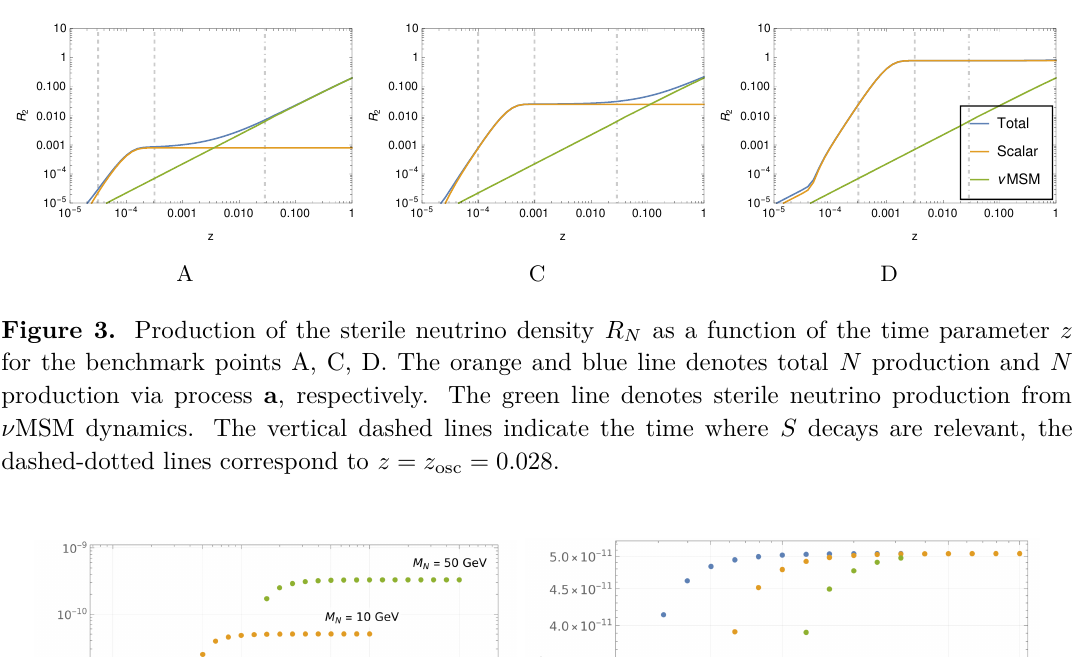
. S = 1 , 10 , 50 GeV. The S self N = 10 GeV. For this figure N